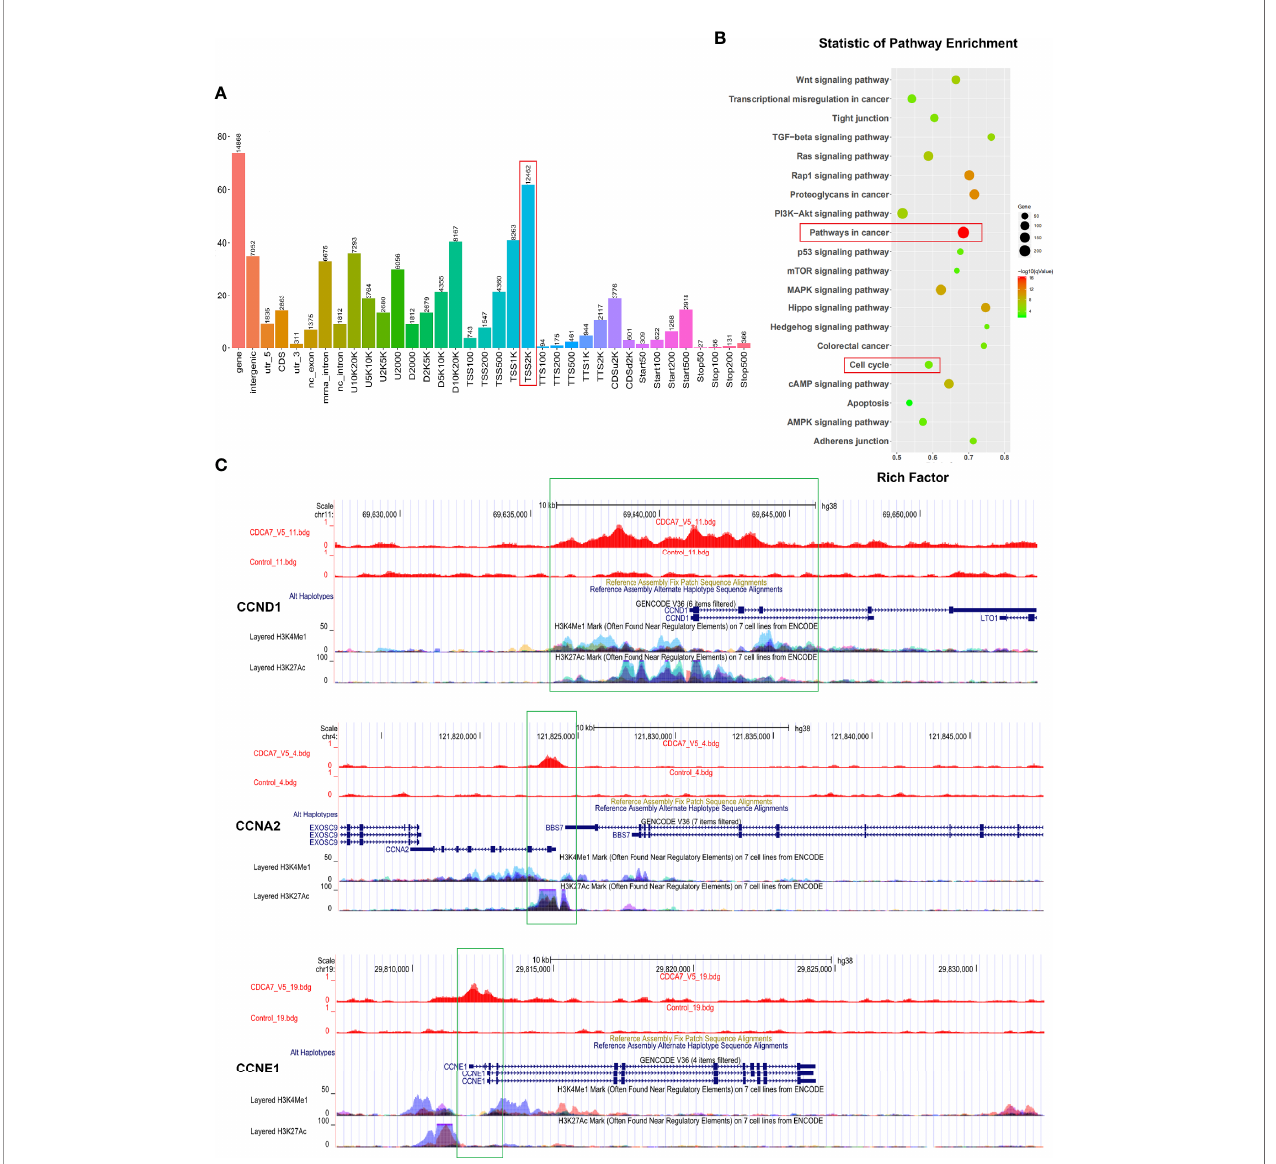
FIGURE 3 | Cyclins may be the downstream genes regulated by CDCA7 as a transcription regulator. (A) Most of the binding sites of CDCA7 with DNA located at the position of 2,000 bp before the transcription initiation site of the genes. (B) The pathway enrichment analysis of the DNA fragments obtained from ChIP- sequencing. (C) CDCA7 binds with CCND1 at the position of − 3,732 to − 2,502 bp, binds with CCNA2 at the position of − 74 to 734 bp, and binds with CCNE1 at the positon of − 53 to 925 bp from each transcription start site,